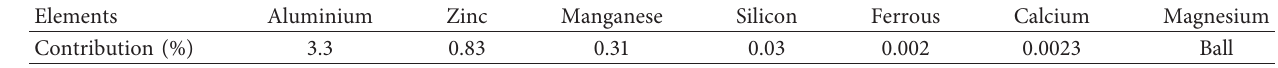
Table 1: Various chemical elements available in magnesium alloy AZ31.